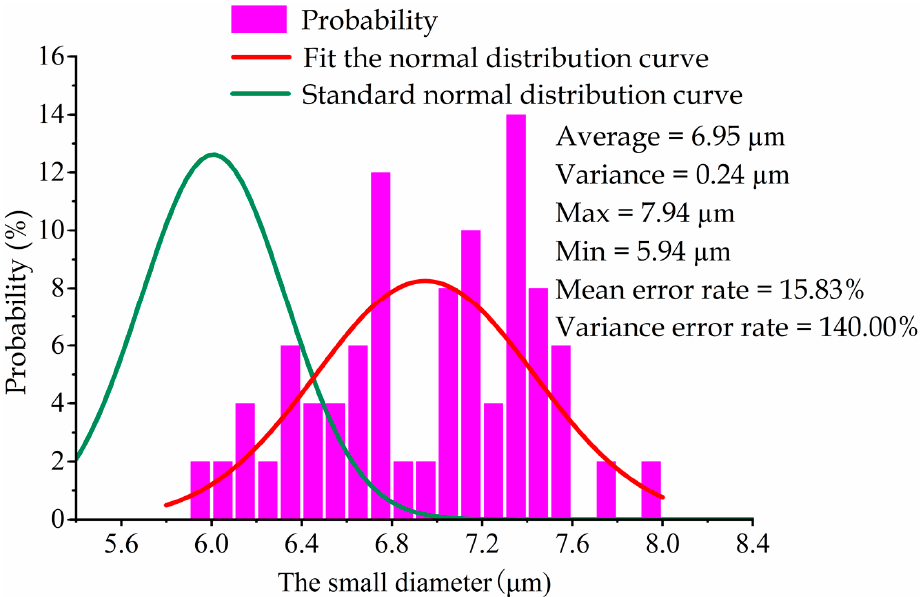
Figure 8. Distribution of the small diameter.